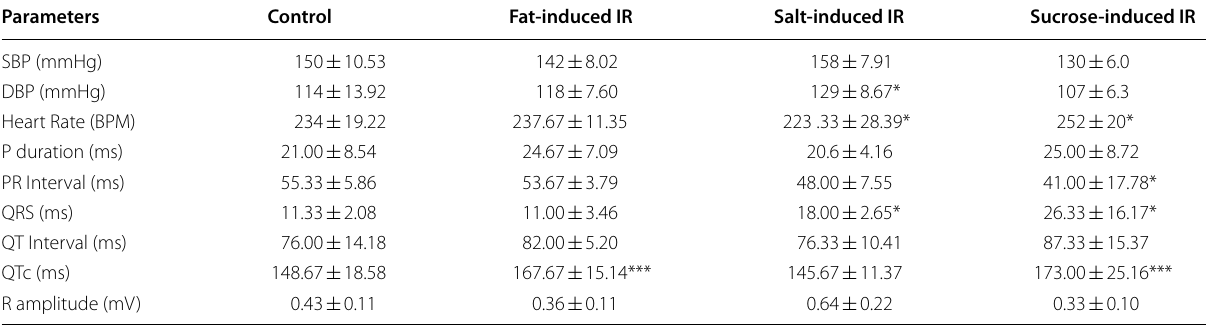
Table 1 The effect of high fat, high sucrose and high salt diet on the systolic pressure, diastolic pressure and ECG of experimental rats. Data are expressed as mean SEM ( n 10) ± =